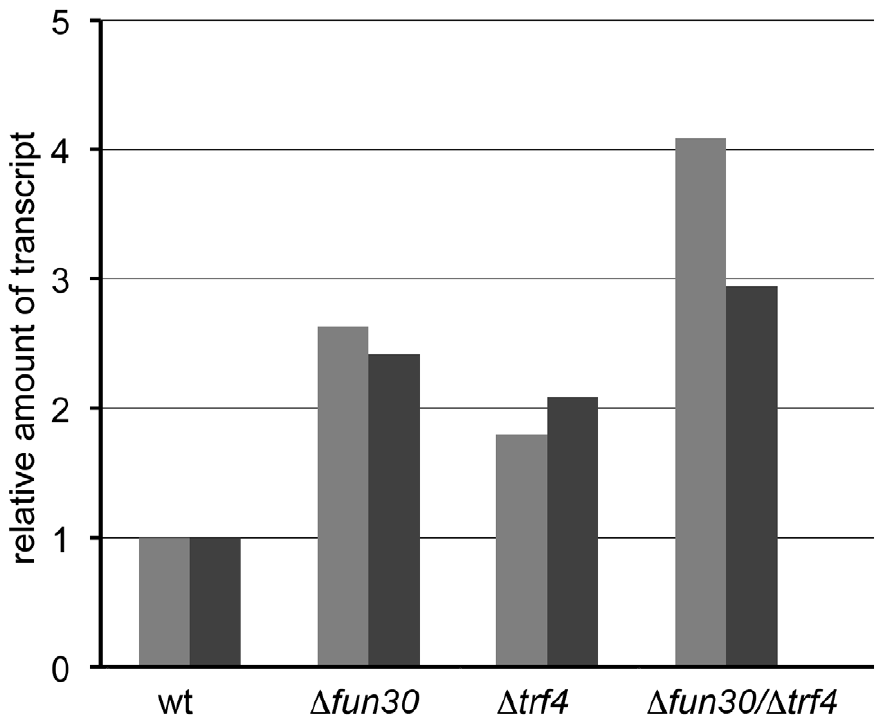
Figure 6. Loss of Fun30 leads to increased Transcription at centromere regions. Analysis of transcript levels at CEN3 region by RT-qPCR in wildtype yeast (wt), the corresponding D fun30 mutant, D trf4 mutant and the double mutant D fun30 D trf4 strains. Primers PM22/48 detecting transcripts directly over CEN3 were used to amplify cDNA. The graph reports the relative amount of transcript compared to a control gene that is not regulated by Fun30. Similar results were obtained when we examined absolute amounts.